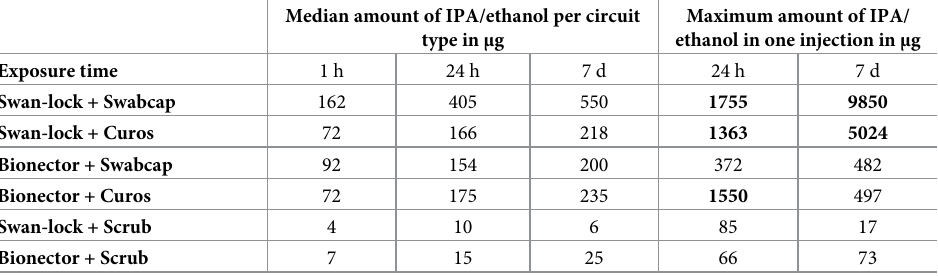
Table 1. Median and maximum leakage per circuit type. Median amount of isopropanol or ethanol per circuit type after 1 hour, 24 hours, and 7 days of cap exposure. Each value presented in the table is a median value of 24 injections administered per circuit type. Maximum amount of isopropanol or ethanol recorded in one injection per circuit type. Amounts > 1130 μ g are marked in bold.